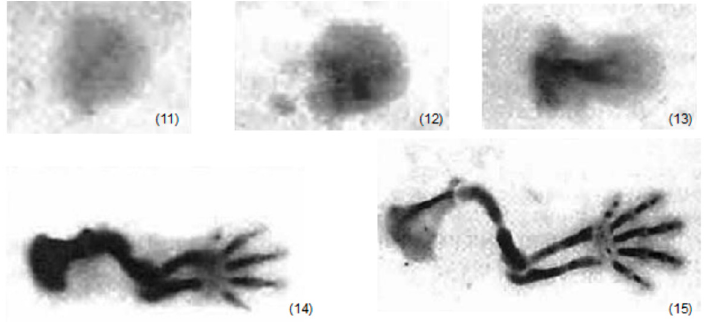
Figure 2. The mouse foot as a living structure emerging from day 11 to 15 [24]. Note: Every step is based on the previous step for enhancing the degree of wholeness. Apparently, the number of centers induced is increased in the course of growth from day 13 to 15.